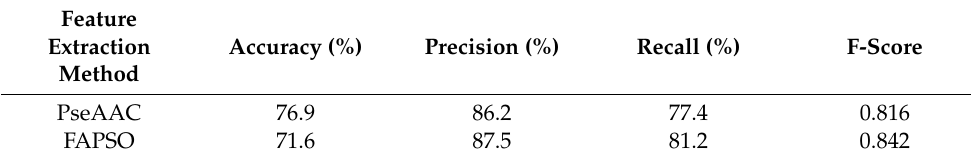
Table 5. GPCR classification performance for sub-subfamily